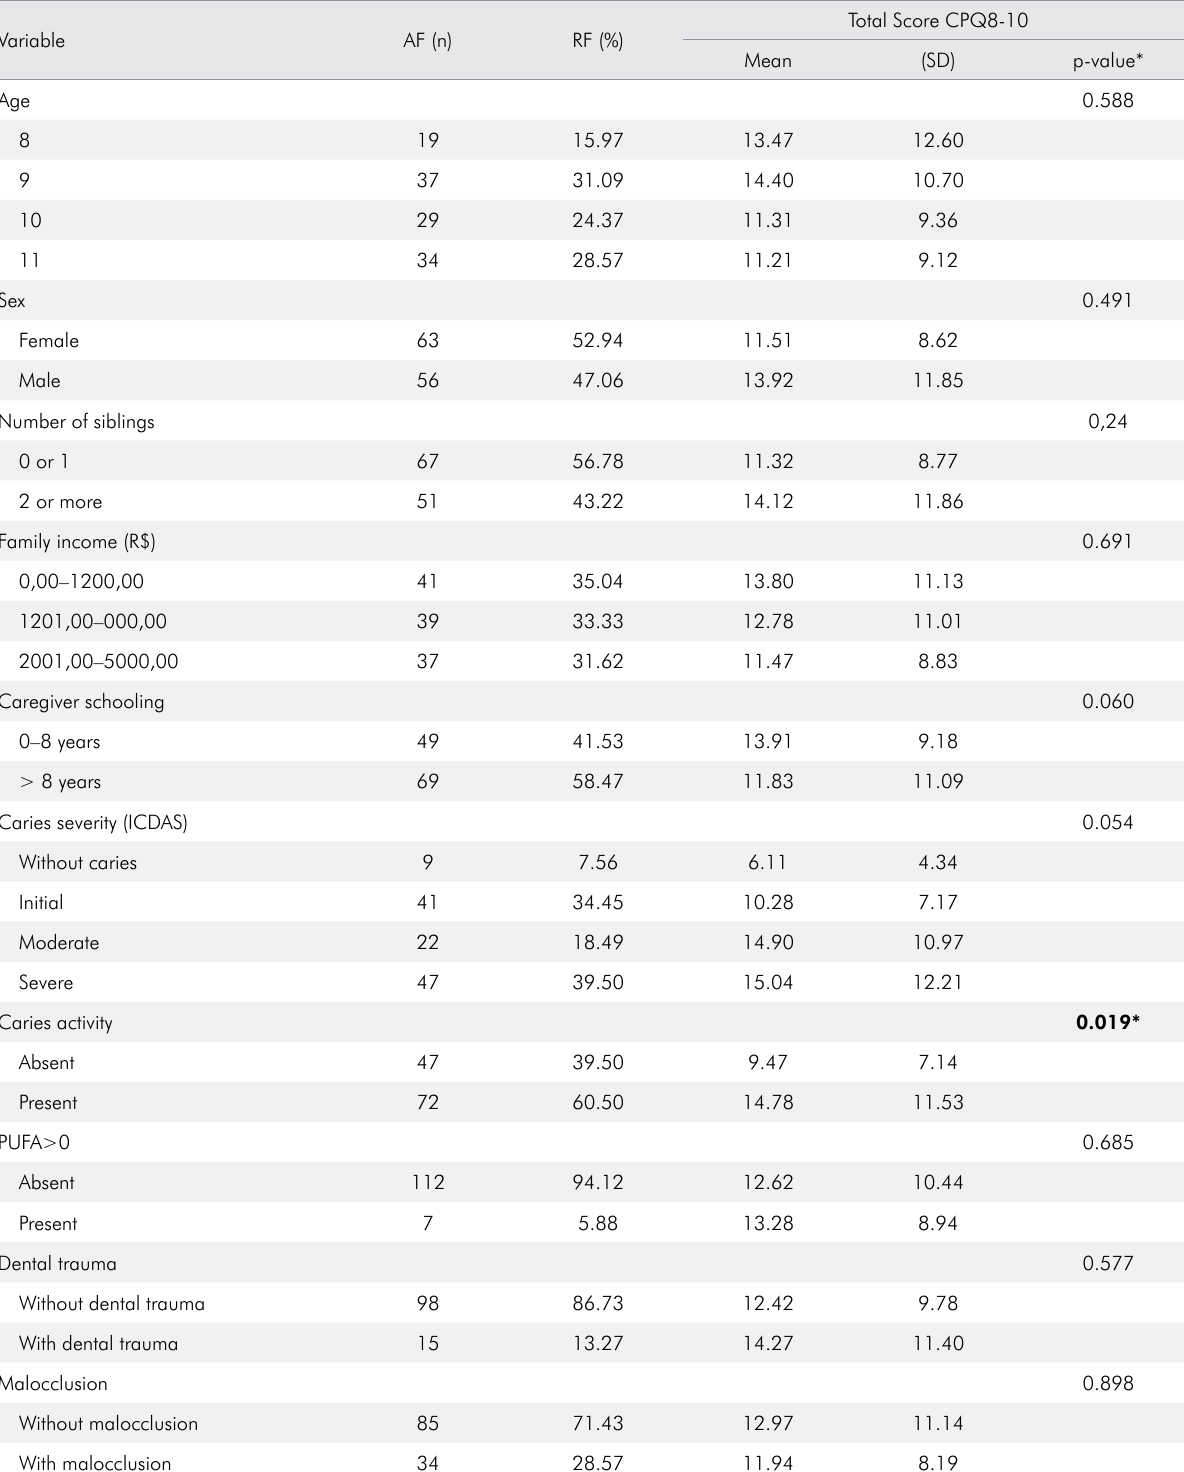
Table 1. Characterization of the sample in relation to demographic, socioeconomic and oral health aspects and the association in relation to oral health-related quality of life (OHRQoL). Pelotas, RS, Brazil (n =